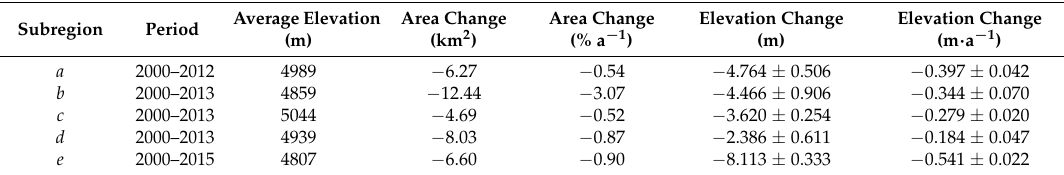
Table 3. Changes in glacier area and ice surface elevation of each subregion of the Upper Reach of Shule River